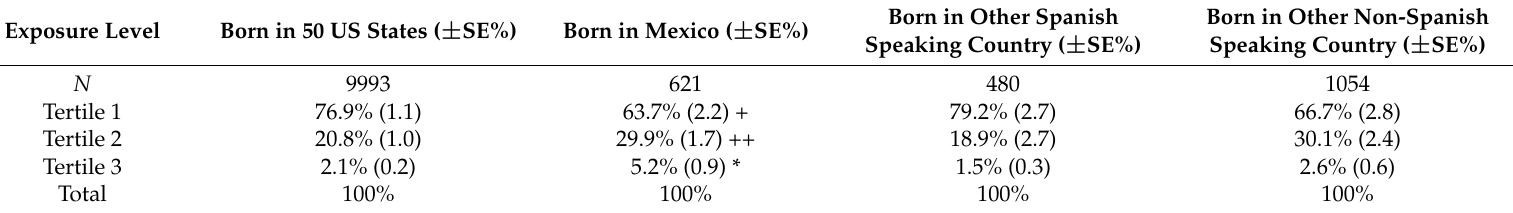
Table 1. Country of Birth and Tertiles of Exposure.